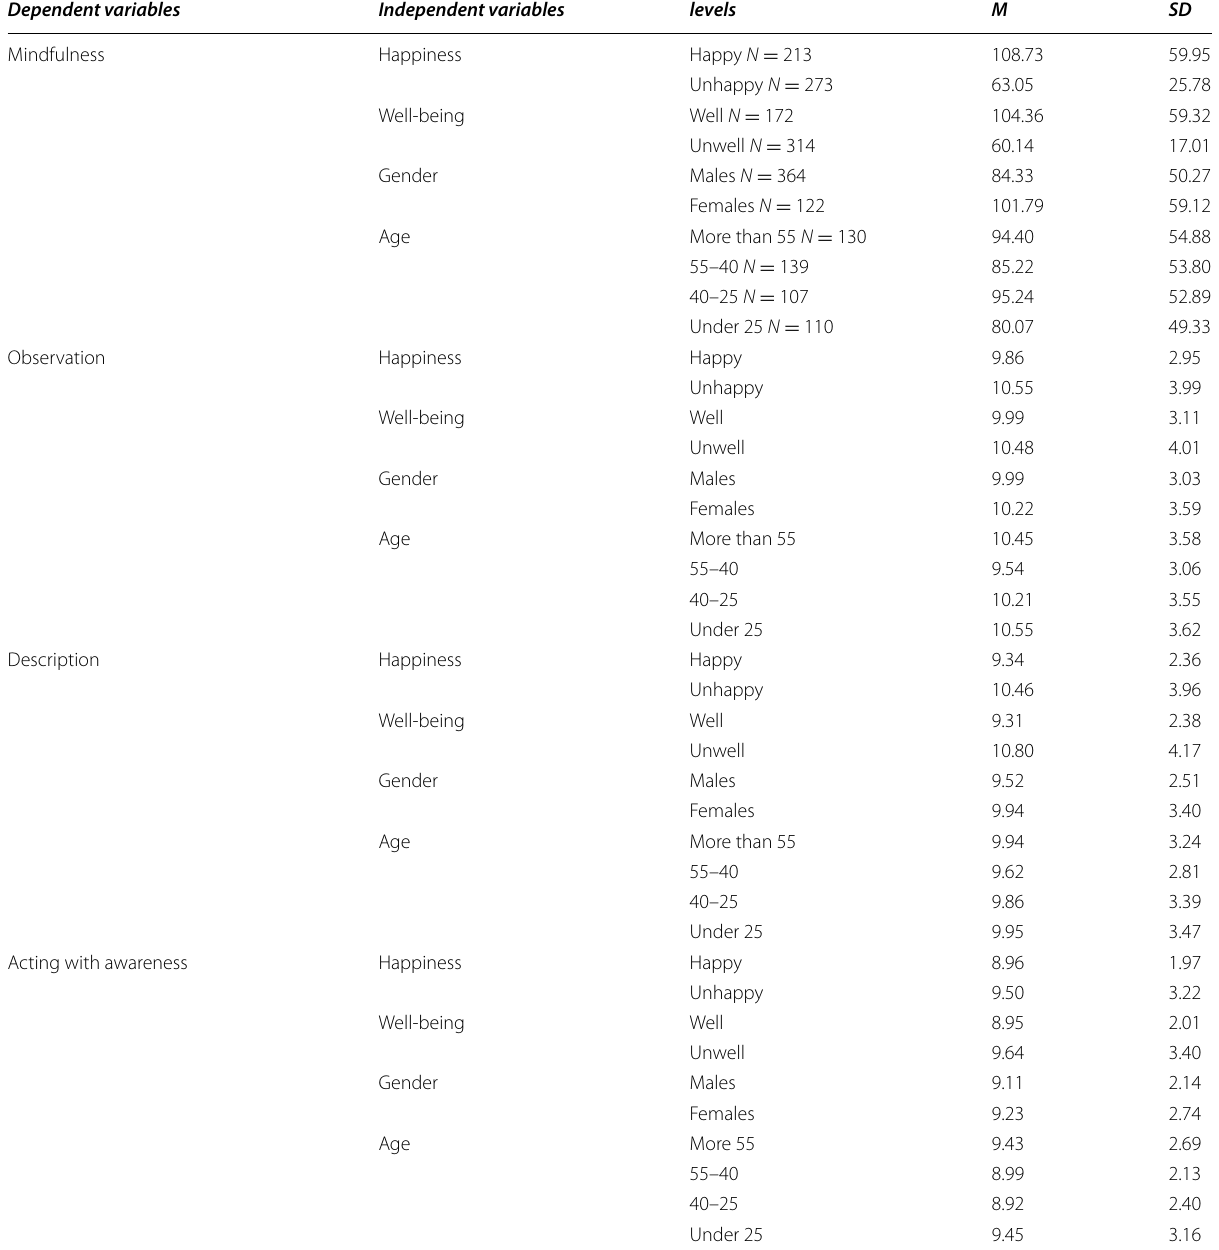
Table 3 Means and standard deviations of mindfulness, self-disclosure, happiness, well-being, gender, and age Dependent